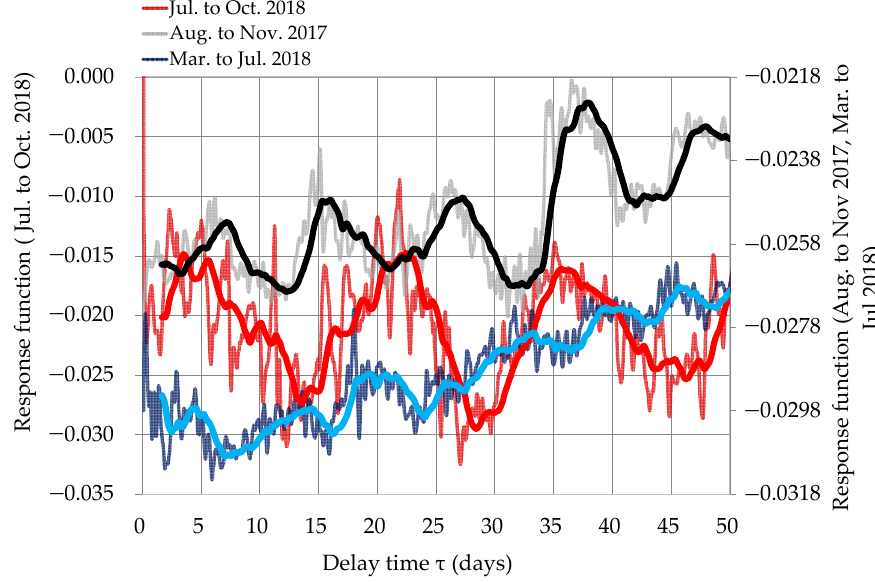
Figure 5. Calculated water-level response functions with respect to average precipitation from August 2017 to October 2018, showing τ < 50 d. The bold line indicates a running mean of approximately 45 d. The dotted circle peaks are regarded as the delay times of the paddy–waterway system. These functions were calculated using MATLAB software, and the figure was drawn using Microsoft Excel.